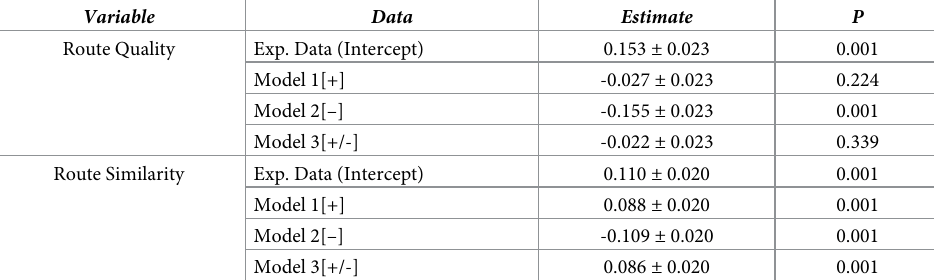
Table 1. Statistical output for simulations with one individual. Comparisons of route quality and route similarity through Binomial GLMMs using bee identity as a random effect (bee identity nested in simulation identity for simu- lated